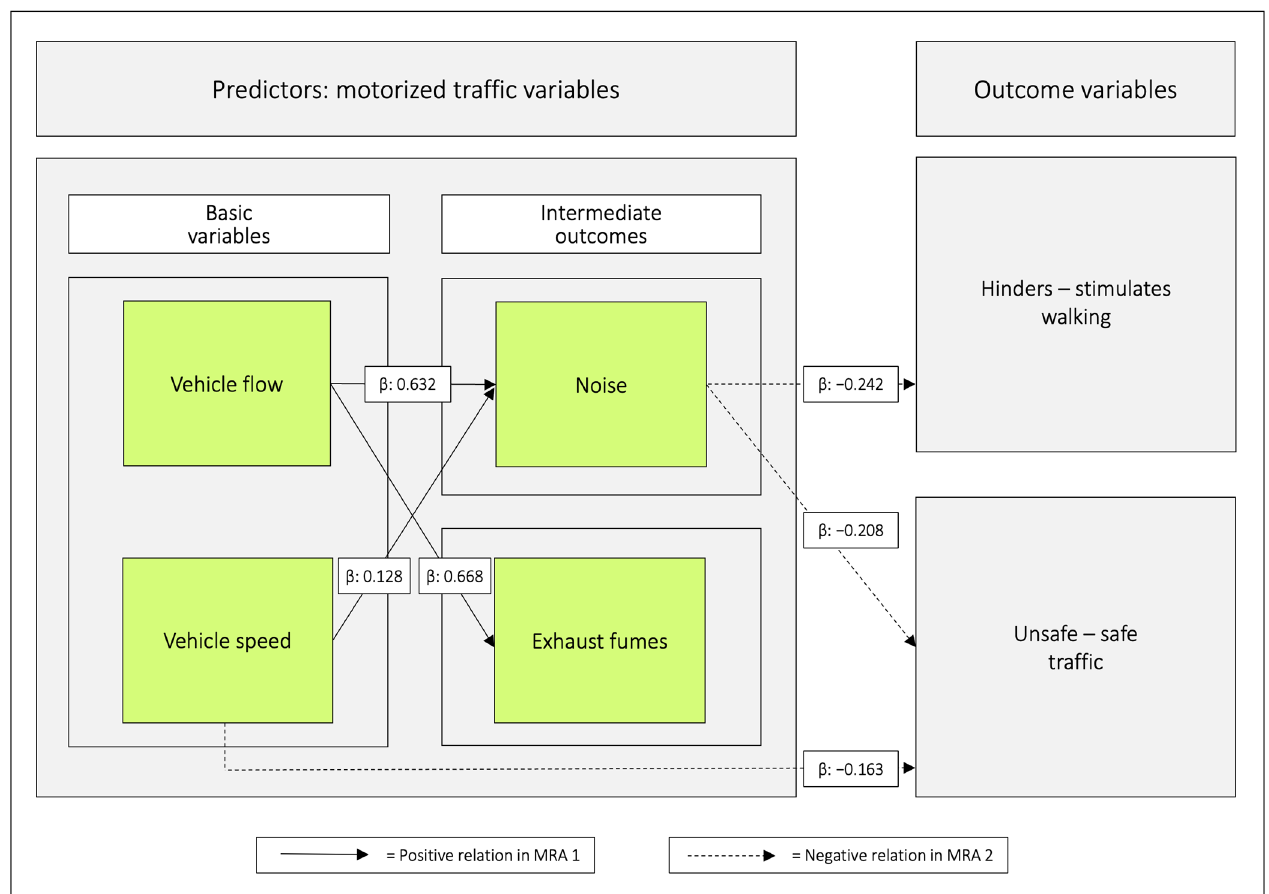
Figure 8. Relations based on multiple regression analysis between the predictor variables (MRA 1), and between the predictor variables and the outcome variables (MRA 2). The solid arrows are based on Table 6. They illustrate that when both vehicle speed and vehicle flow are analysed jointly as predictors, they relate positively with noise whereas only vehicle flow relates to exhaust fumes . The dashed arrows are based on Tables 7 and 8. They illustrate that when all traffic variables are analysed jointly as predictors, only noise relates negatively to both outcome variables. Vehicle speed has the same role in relation to unsafe–safe traffic . β = unstandardized beta. Table 8. Relations between combinations of predictor variables and the outcome unsafe–safe traffic .